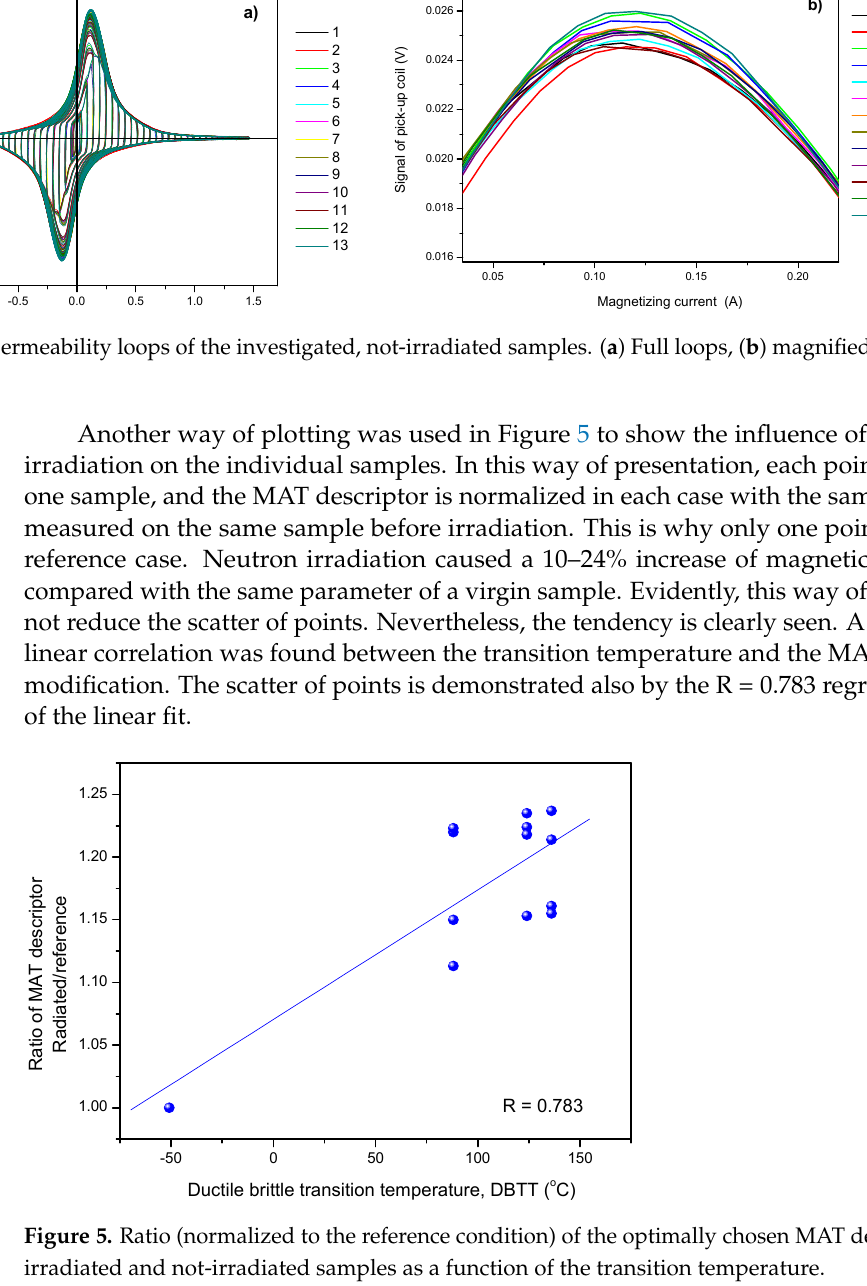
Figure 3. Optimally chosen MAT descriptors as a function of the transition temperature for the material 15Kh2NMFA.